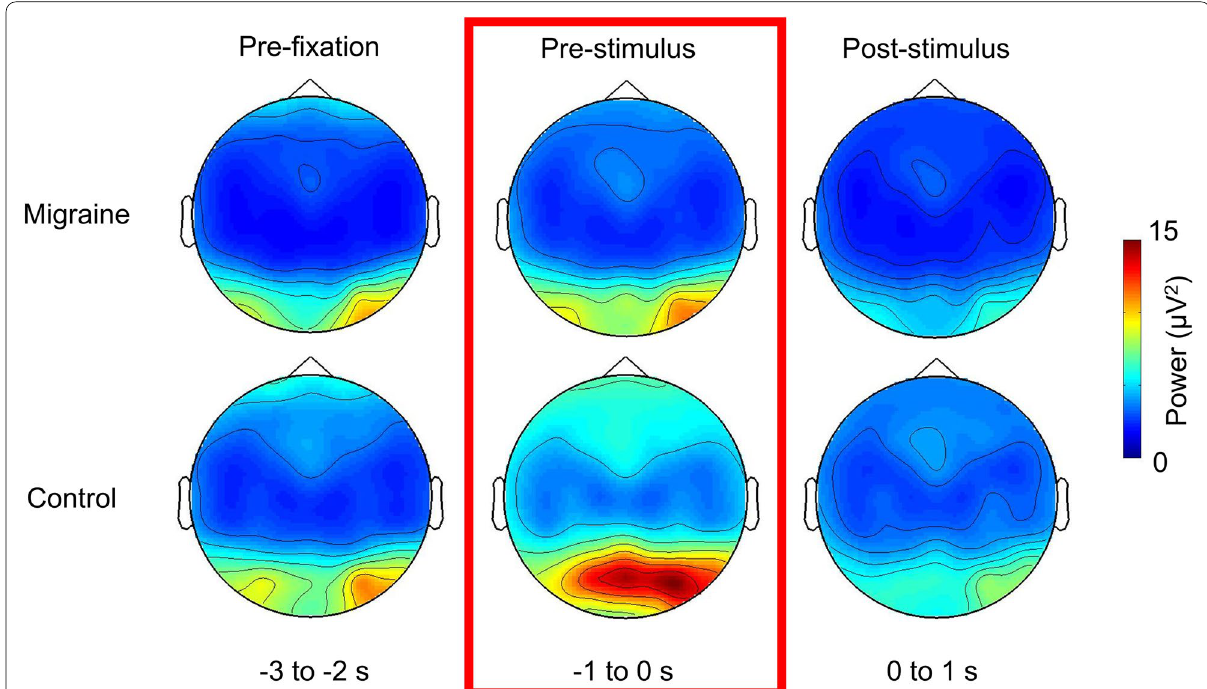
Fig. 4 Topographies of the alpha power for pre-fixation, pre-stimulus and post-stimulus period (collapsed 3 grating conditions). The pre-stimulus alpha power for migraineurs was significantly lower than controls in the occipital-parietal region, suggesting a more excitable visual-associated